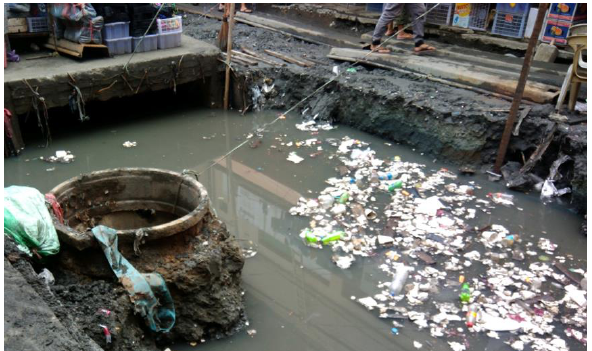
Figure 3. An exposed culvert discovered by the validation fieldwork team.